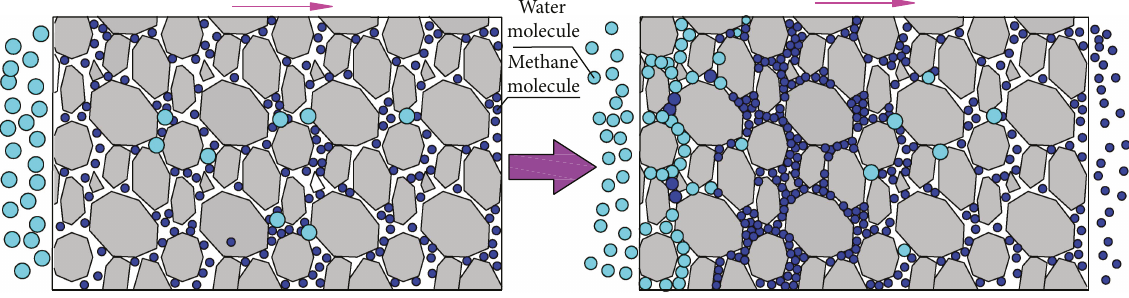
Figure 2: Conceptual model of methane driven by water in porous coal